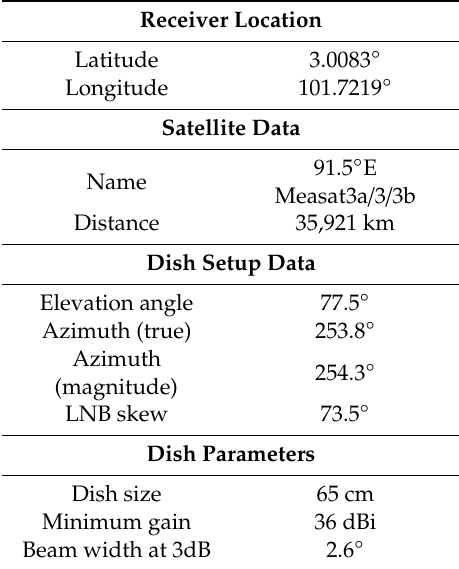
Figure 7. Experimental site ( a ) receiving systems experimental setup ( b ) parabolic dish antenna. Table 6. Receiver system parameters.